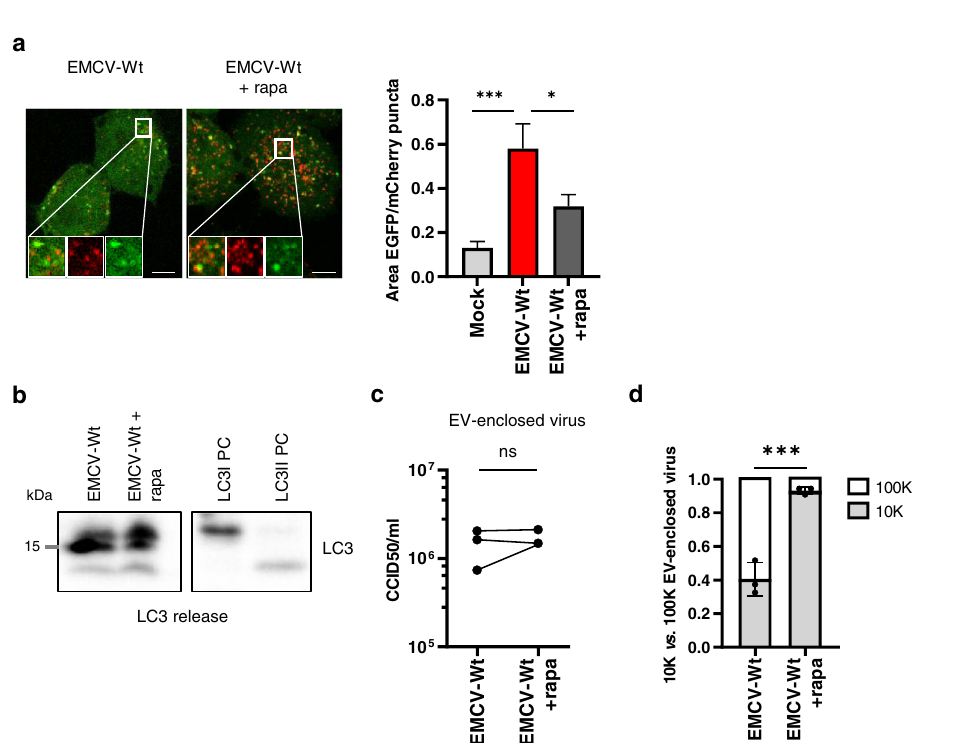
Fig. 5 Enhancing autophagic degradation does not inhibit Leader-induced secretory autophagy and EV-enclosed virus release. EMCV-Wt infected cells were treated with 200 nM rapamycin 1 h p.i. onwards to increase autophagic fl ux and enhance autolysosome formation. a Representative confocal microscopy images of infected mCherry-EGFP-LC3 reporter cells 6 h p.i. Bar graphs display the ratio between the total surface area of EGFP and mCherry positive puncta, that correspond to autophagosomes (EGFP + mCherry + ) and autolysosomes (EGFP − mCherry + ). Indicated are mean values ± SEM of ≥ 7 separate images with 2 – 5 cells each from a representative of n = 3 individual experiments. *** p = 0.0008, * p = 0.0434 as assessed by one-way ANOVA with Tukey ’ s multiple comparison test. Scale bar = 10 μ m. b Western blot analysis of LC3 release in ultracentrifugation pellets harvested 8 h p.i. from cell supernatants of an equal number of cells. Depicted is a representative image of n = 3 independent experiments. LC3I PC and LC3II PC are positive control samples for western blot detection of LC3I and LC3II, respectively. c , d 10 K and 100 K EVs were isolated and puri fi ed using density gradients. Depicted is the total amount of EV-associated infectivity ( c ) and its distribution over 100 K vs. 10 K EVs ( d ) (mean ± SD of n = 3 independent experiments) as determined by end-point dilution assay. *** p = 0.0009, ns p = 0.6599 as assessed by an unpaired, two-tailed t -test. Source data are provided as a Source Data fi